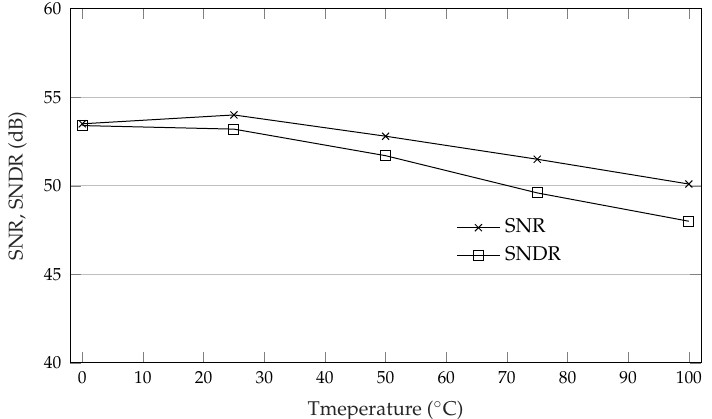
Figure 12. Simulated SNR and SNDR over